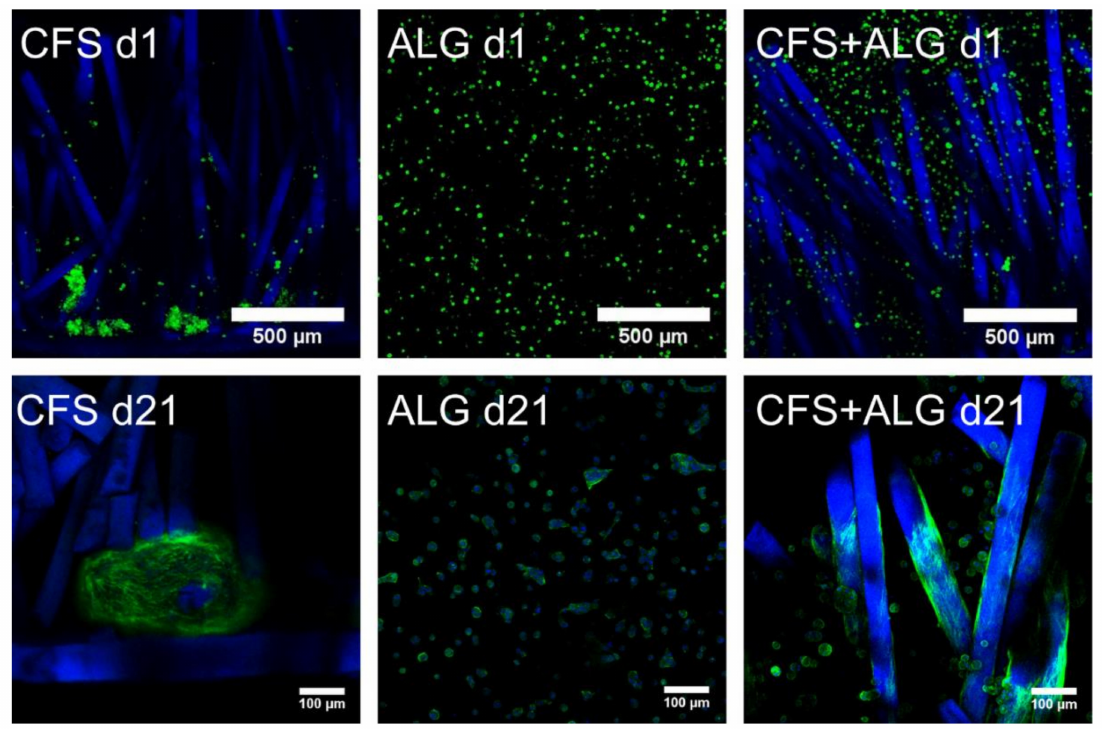
Figure 4. Representative cLSM images of chitosan flock scaffolds 1 and 21 days after seeding with human chondrocytes in chitosan flock scaffolds (CFS), alginate hydrogels (ALG), and chitosan/alginate flock scaffolds (CFS+ALG); Actin cytoskeletons of cells stained with Alexa-flour 488 Phalloidin (green), cell nuclei (stained with DAPI), and chitosan fibers appear blue because of autofluorescence. Reconstructions from cLSM image stacks. Scale bars represent 500 µ m (day 1) or 100 µ m (day 21), respectively.